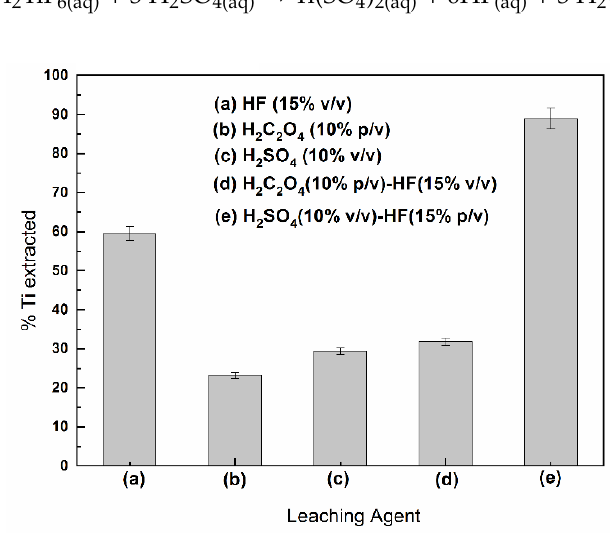
Figure 3. E ff ect of the leaching agent. Figure 3. Effect of the leaching agent.